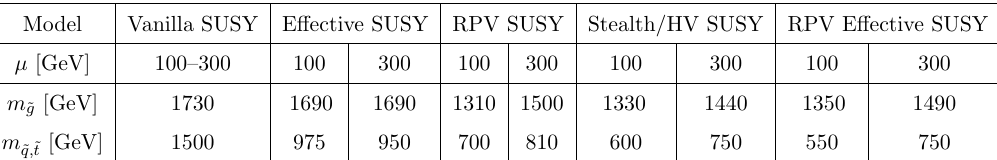
for each model t